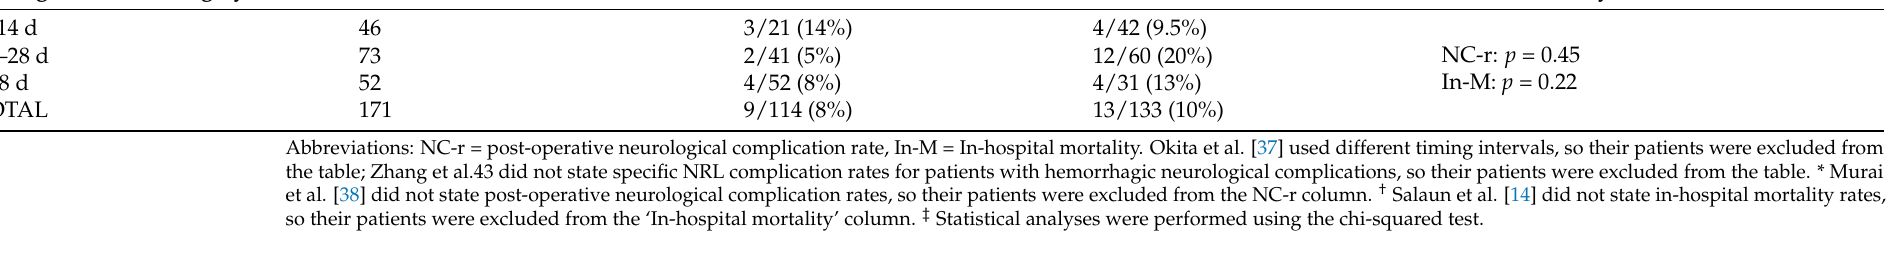
Table 4. Management of neurological complications of infective endocarditis according to ESC and AHA current guidelines, compared to author’s own